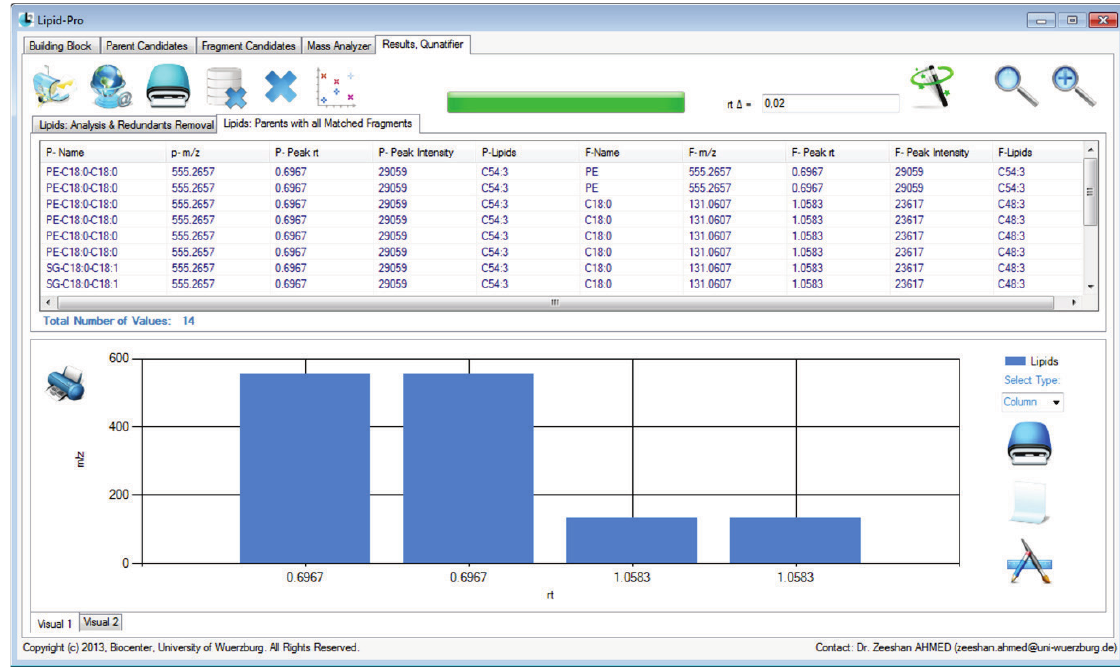
Figure 12. Lipid-Pro’s main graphical user interface. Scientific software solution towards lipidomics and pharmaceutical biology (http:// www.neurogenetics.biozentrum.uni-wuerzburg.de/en/project/services/lipidpro/).